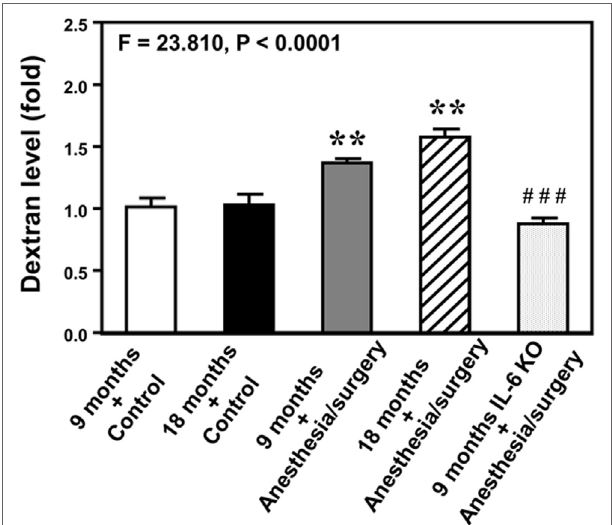
( Figure 5A , F = 0.300, P = 0.937). The anesthesia/surgery did not significantly change the platform crossing times ( Figure 5C